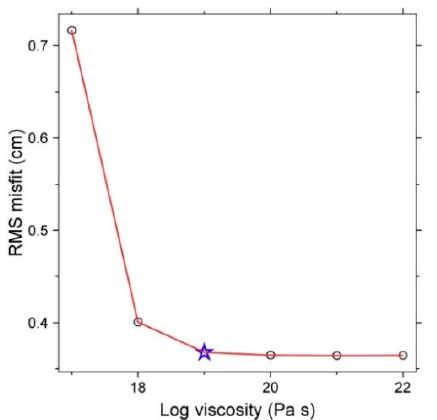
Figure 9. Relationship curve between the log viscosity and the RMS misfit for the combined observations at the eight time epochs. The blue hollow star denotes the preferred lower bound of the viscosity, 1 × 10 19 Pa·s. Beyond this value the RMS misfit nearly no longer changes with